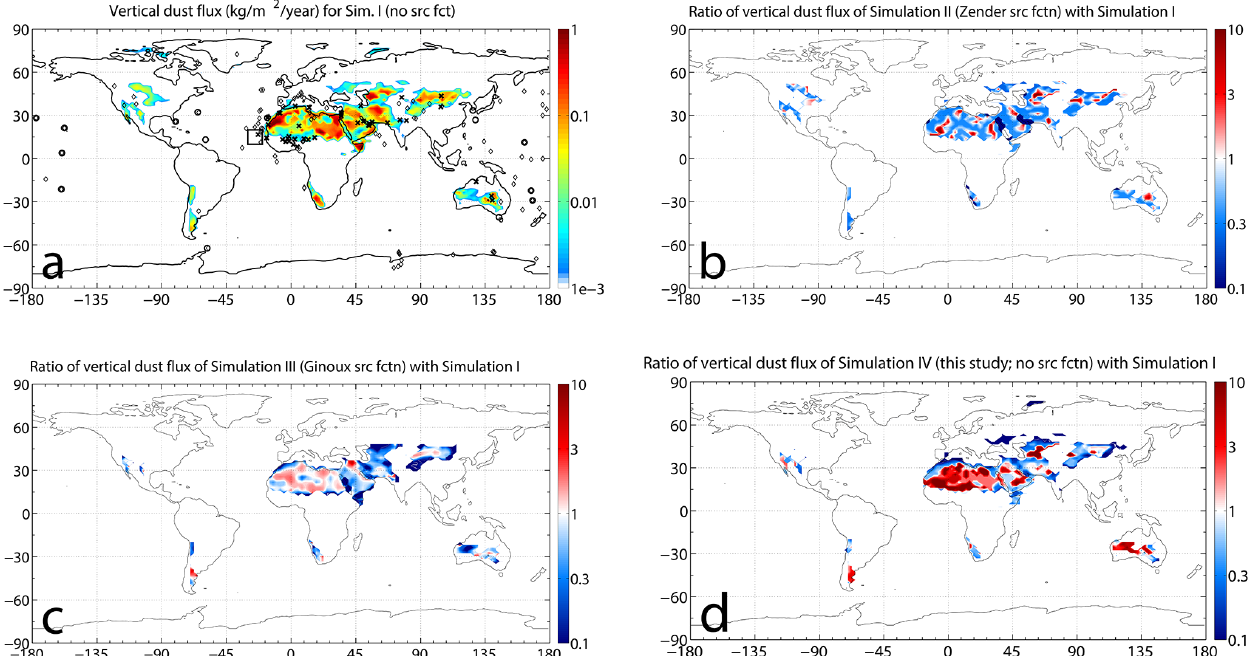
Figure 3. Global maps of (a) the simulated vertical dust flux for simulation I and ( b–d ) the ratios of the dust flux in simulations II–IV to the flux in simulation I. Red (blue) coloring in panels (b–d) denotes increases (decreases) in dust emission fluxes relative to the “control” (simulation I). In panel (a) , crosses, circles, and diamonds respectively mark the locations of measurements of AERONET AOD, dust surface concentration, and dust deposition flux. The square denotes the area off the coast of West Africa for which the satellite-derived dust AOD and DMP were used (Evan et al.,